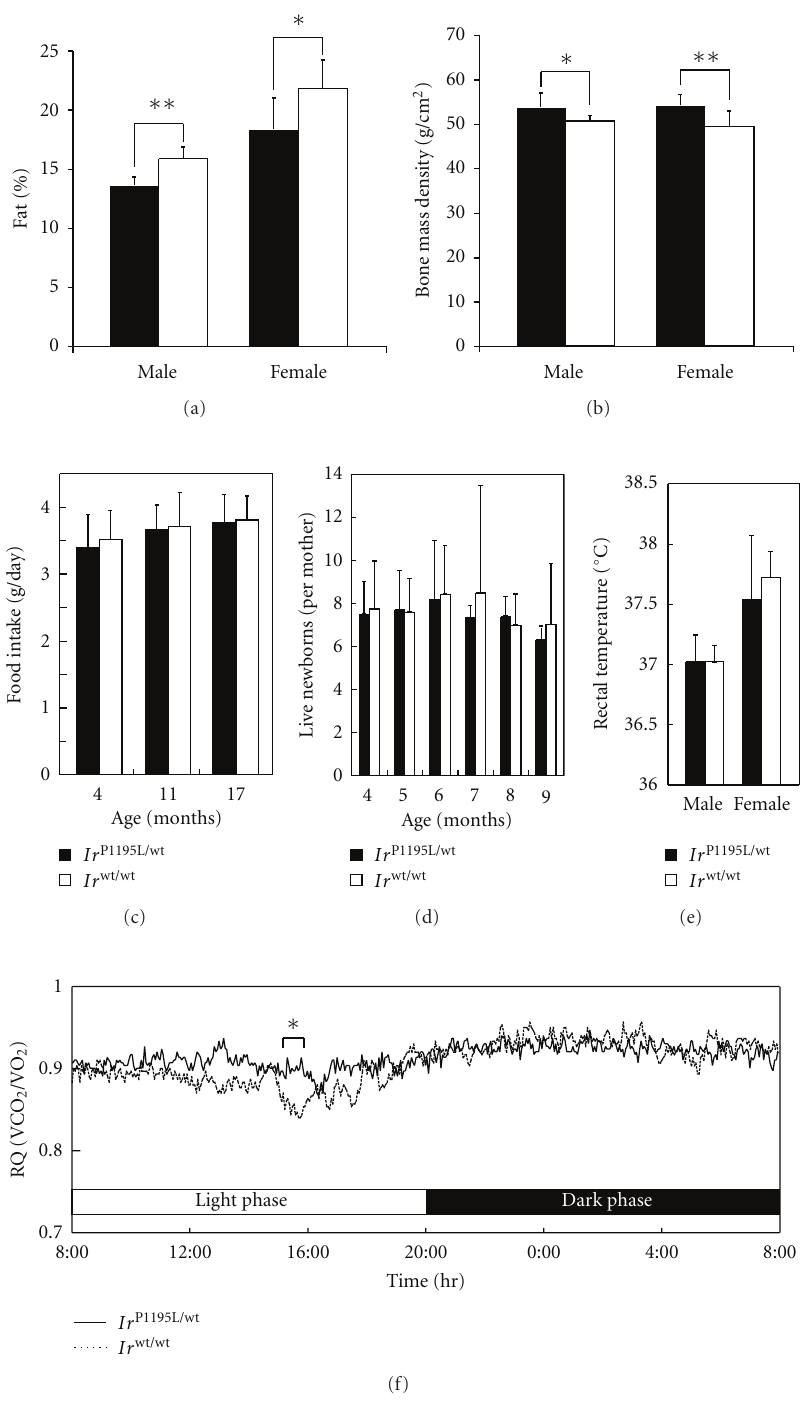
Figure 4: Adiposity, bone density, food intake, reproduction, rectal temperature, and respiratory quotients of the Ir P1195L / wt mice. (a) Both male and female Ir P1195L / wt mice showed a significantly decreased fat ratio compared to Ir wt / wt mice at 20 months of age. (b) Both male and female Ir P1195L / wt mice showed significantly increased bone density compared to the Ir wt / wt mice at 20 months of age. Aged Ir P1195L / wt male ( n = 6), Ir P1195L / wt female ( n = 6), Ir wt / wt male ( n = 6), and Ir wt / wt female ( n = 5) mice were evaluated by DEXA. (c) The food intake of Ir P1195L / wt male and Ir wt / wt male mice at 4, 11, and 17 months of age. No significant di ff erence was observed between the food consumption by Ir P1195L / wt ( n = 10) and Ir wt / wt ( n = 12) mice. (d) The reproduction rate of Ir P1195L / wt female mice. No significant di ff erence was observed between Ir P1195L / wt and Ir wt / wt mice (at least 3 mice per genotype). (e) The rectal temperatures of Ir P1195L / wt and Ir wt / wt mice at 4 months of age. No significant di ff erences were observed in the temperatures between the Ir P1195L / wt and Ir wt / wt mice ( n = 4 for each genotype). ∗ P < 0 . 05, ∗∗ P < 0 . 005 by Student’s t - test. (f) The mean time course of respiratory quotients (RQ = VCO 2 /VO 2 ) of male mice at 5 months of age. The values represent the mean of 24 hours of measurements from each animal ( n = 3, male). ∗ P < 0 . 05 by Student’s t -